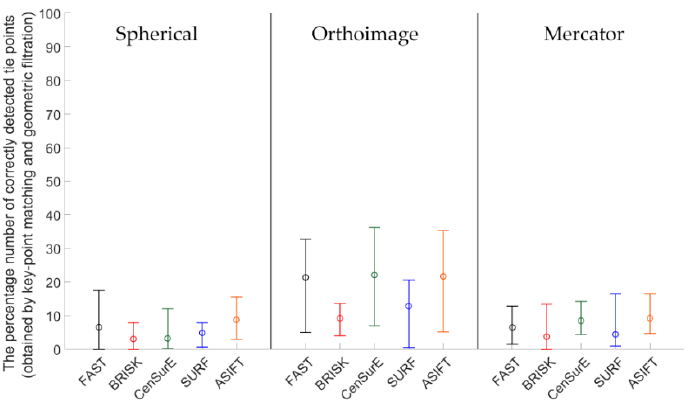
Figure 7. Diagram of the mean (circles), maximum, and minimum percentage of correctly detected and matched key points using blob (ASIFT, SURF, and CenSurE) and point (FAST and BRISK) detectors for rasters in the spherical projection, orthoimages, and the Mercator projection; Test Site I.